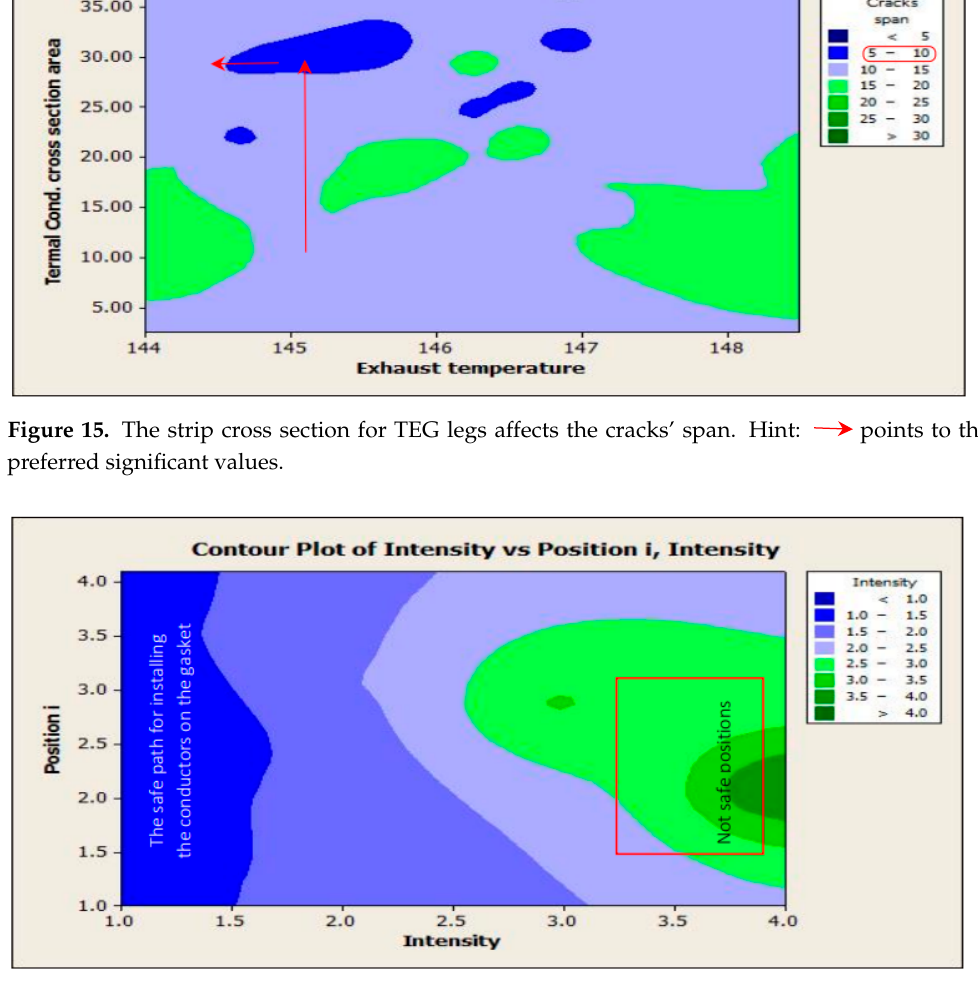
Figure 16. The intensity of the cracks’ positions for the thermal conductor terminals.